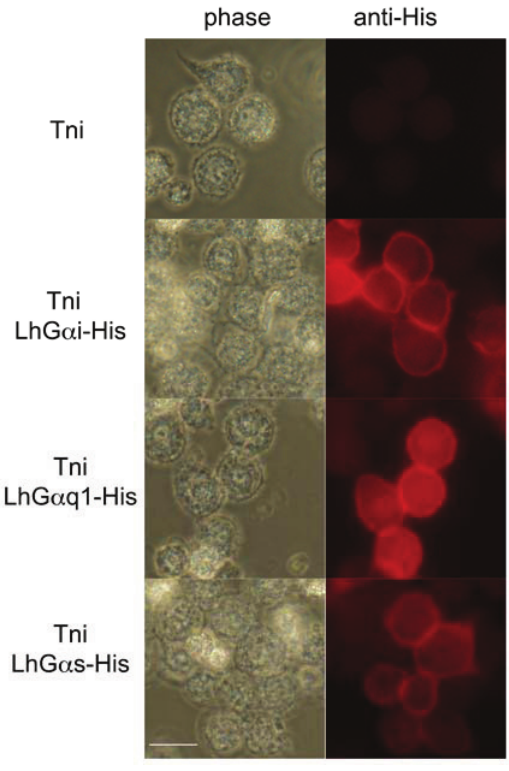
Figure 6. Intracellular localization of transiently expressed L. hesperus G(cid:2) subunits in cultured insect cells. Fixed Trichoplusia ni (Tni) cells transfected with plasmids encoding carboxyl terminal 6×-His tagged LhG(cid:2) subunits (LhG(cid:2)i-His, LhG(cid:2)q1-His, and LhG(cid:2)s-His) or mock transfected cells (Tni) were probed with a polyclonal mouse anti-His antibody (primary) and a goat anti-mouse IgG-TRITC antibody (secondary). Red fluorescence corresponds to the TRITC signal and denotes localization of the His-tagged G(cid:2) subunits. Scale bar = 20